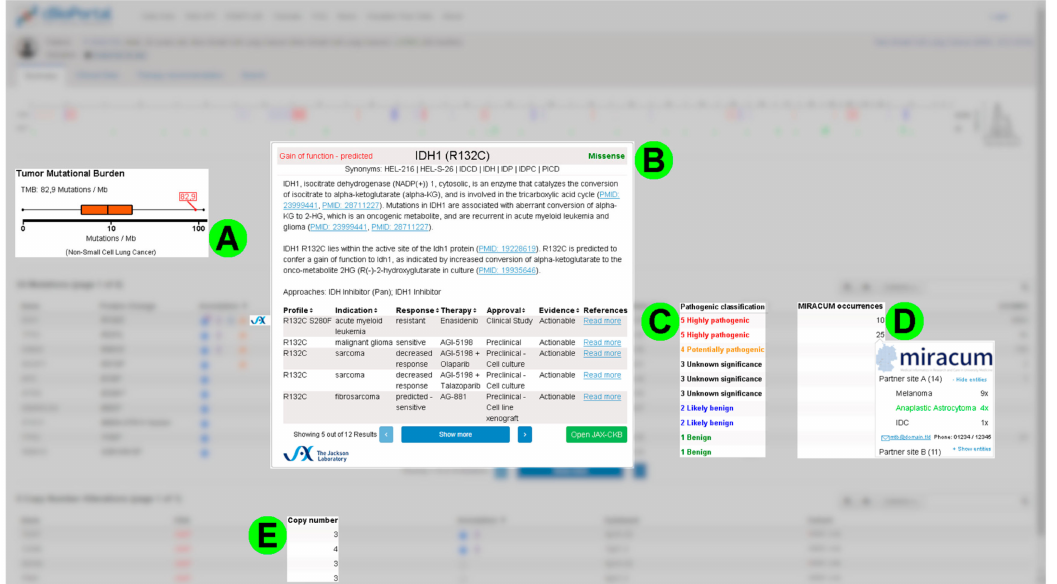
Figure 2. Collage demonstrating some requirements for the case analysis. This collage is a synthesis of di ff erent screenshot mockups, which exemplarily illustrates some requirements for individual case analysis: ( A ) A visual representation of the tumor mutational burden relative to the expected range of the corresponding tumor entity using a box plot. ( B ) Integration of data from the JAX Clinical Knowledgebase(JAX-CKB)viaannotationandpop-up. ( C )Classificationofpathogenicityasanexample of data extension in the mutation table of the patient view. ( D ) Tool for an entity-specific display of how often a certain mutation was found and classified as relevant for the therapy recommendation at the partner sites. If necessary, the contact data may be used to exchange experiences. ( E ) Extension of the table with copy number variation (CNV) data by the exact number of copies. Example data adopted from the public cBioPortal (https: // cbioportal.org) and JAX-CKB knowledgebase